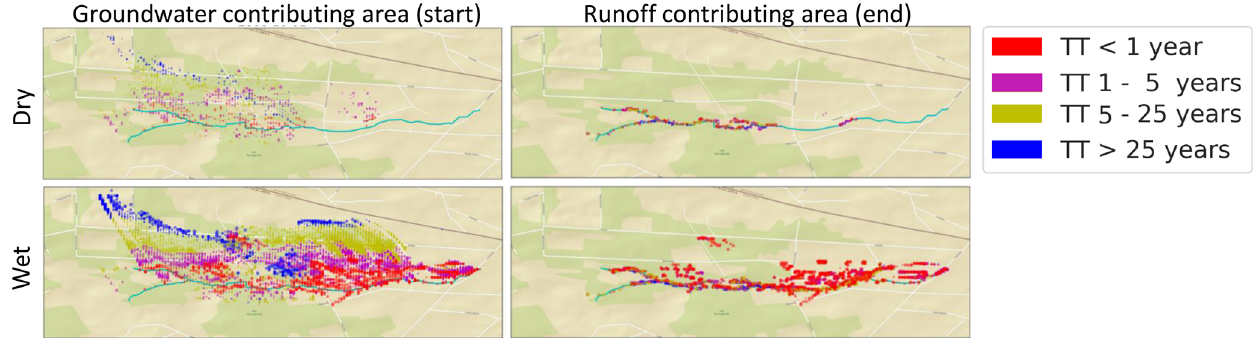
Figure 9. Contributing area in the model for a dry (top; summer 2006) and a wet (bottom; winter 2006–2007) period. Colours represent the travel time towards the stream with blue TT > 25 year and red TT < 1 year (similar to Fig. 2). Notice the large increase in the runoff contributing area in the downstream part of the catchment during wet periods which results from the extensive agricultural drainage system. Background map source: ESRI_StreetMap_World_2D, available at: http://services.arcgisonline.com/ArcGIS/rest/services/ESRI_StreetMap_ World_2D/MapServer (last access: 28 June 2020).